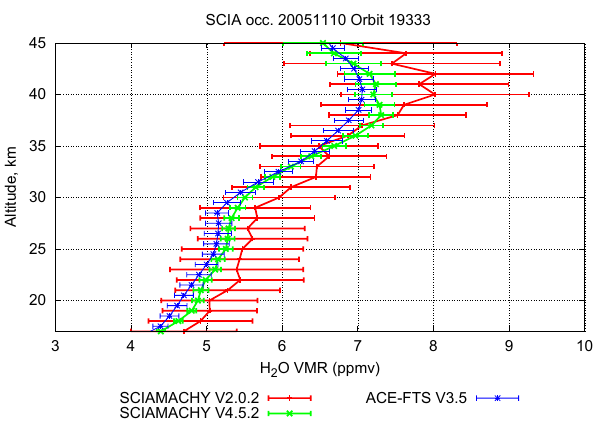
Figure 3. Example of H 2 O VMR profiles. Red: previous product (V2.0.2) from Noël et al. (2010). Green: current product (V4.5.2). Blue: collocated profile from ACE-FTS